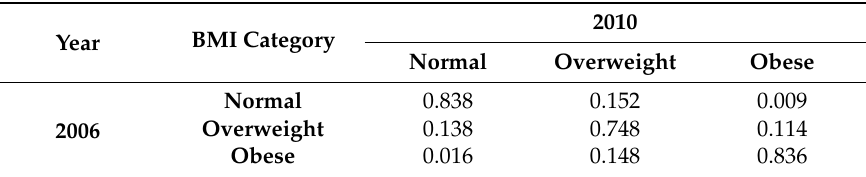
Table 3. Transition probabilities of BMI